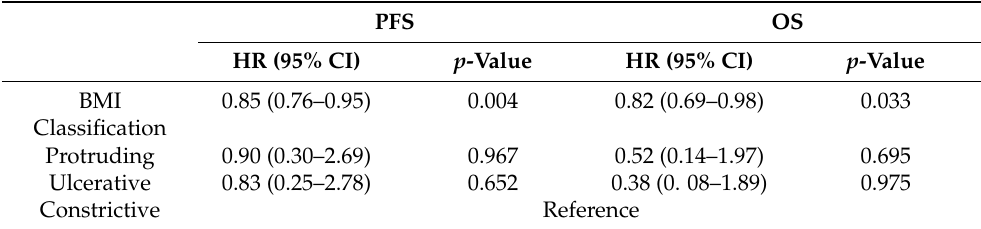
Table 5. Prognostic factors in ICIs group by COX